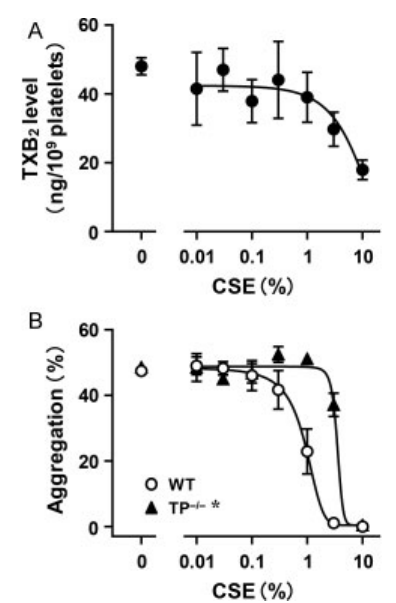
Fig.2 ContributionofreductioninTXA 2 productiontotheinhibitoryeffect of cigarette smoke extract (CSE) on platelet aggregation. ( A ) To estimate the degree of TXA 2 production in platelets, we measured the content of TXB 2 , a stable TXA 2 metabolite. Arachidonic acid (1 μ M) was added to washed platelets to induce TXA 2 production and incubated for 5 minutes. CSEwasaddedattheindicatedconcentrationtowashedplatelets5minutes before the addition of arachidonic acid. Each value is the mean (cid:1) SEM, n ¼ 9. ( B ) Effects of CSE on collagen-induced aggregation of platelets preparedfromWTandTP – / – mice.Collagenwasaddedataconcentrationto induce platelet aggregation of 40 to 55% (WT, 1.0 – 1.5 μ g/mL; TP – / – , 2.5 – 3.5 μ g/mL). CSE was added at the indicated concentration to PRP 1 minute before the addition of collagen. Each value is the mean (cid:1)